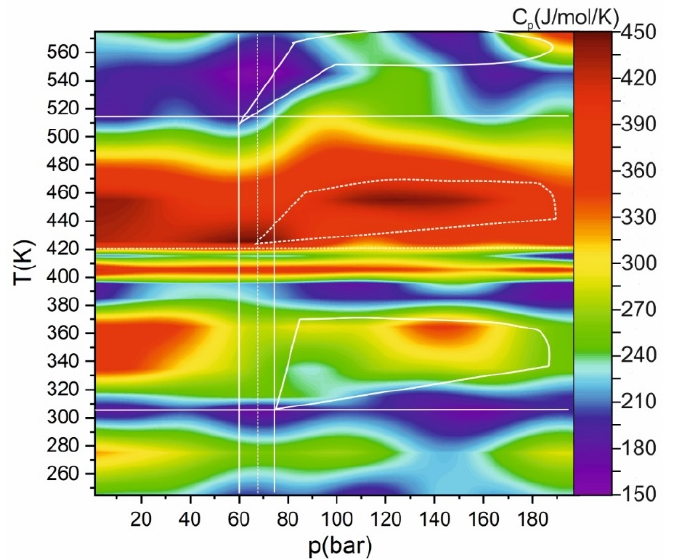
Figure 7. Heat map of specific isobaric heat capacity C p on pressure and temperature. Solid lines show the critical temperature and pressure of carbon dioxide and ethanol; dashed lines show critical mixture parameters. The highlighted areas correspond to the Widom (solid lines for carbon dioxide and dashed lines for mixtures).